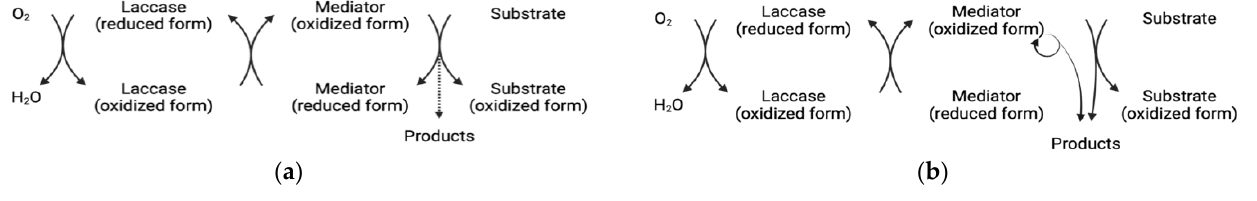
Figure 3. Ideal Lac-mediator reaction model ( a ). Alternative Lac-mediator reaction model ( b ). Adapted from Ref. [81], with permission from Elsevier. License number: 5394140329531.